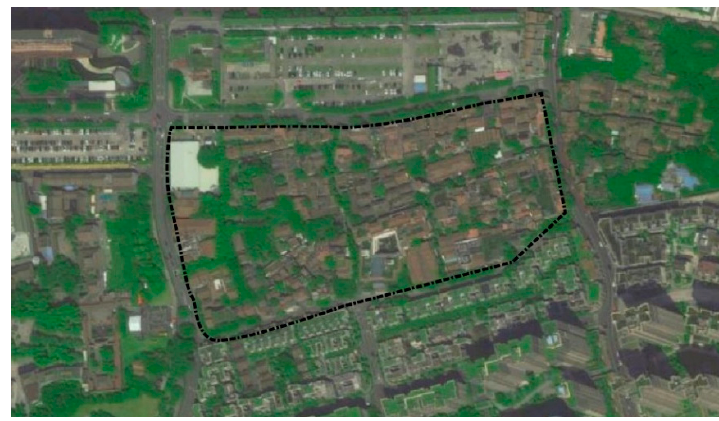
Figure 5. The location of the Ling Nan Tian Di block.